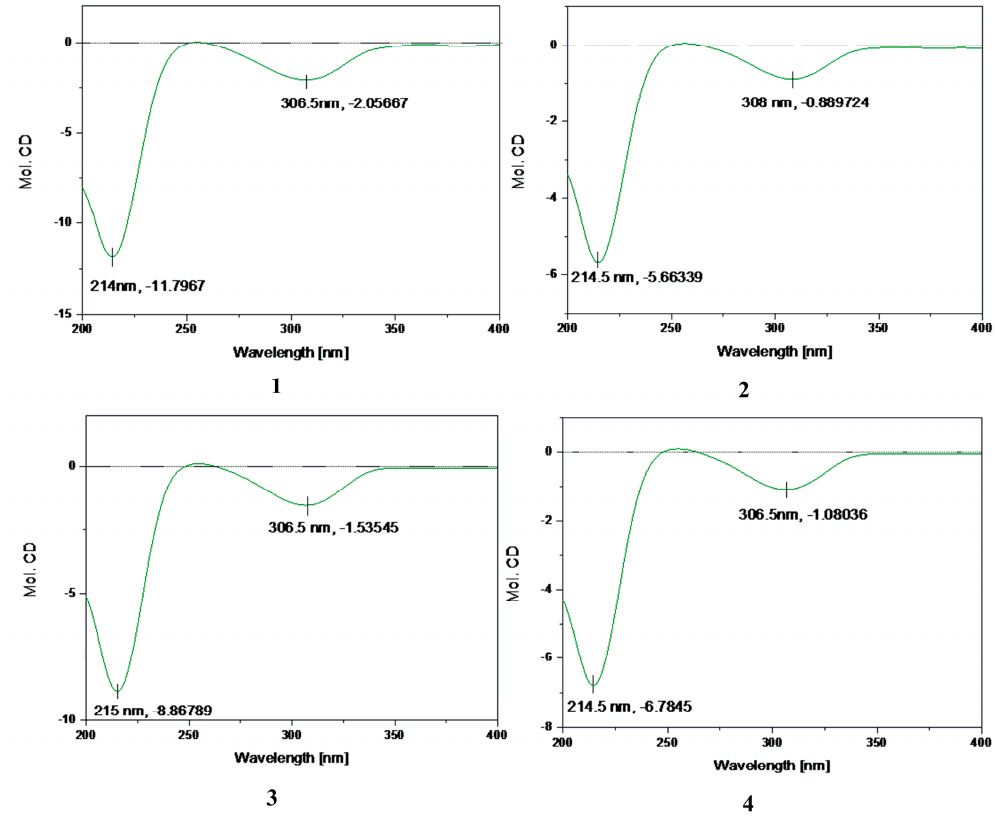
Figure 2. CD spectra of compounds 1 – 4 .